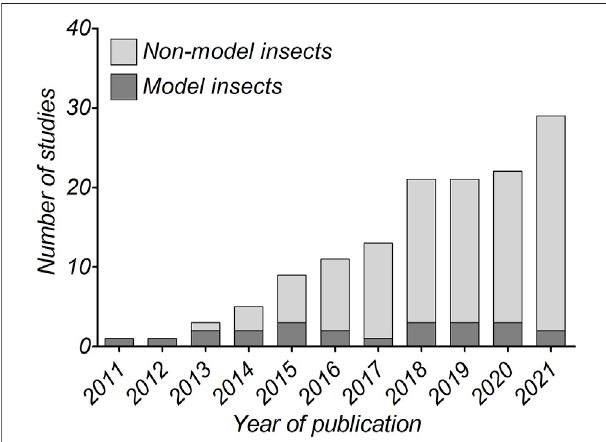
FIGURE1| Numberofstudiespublishedinthelast10 yearsonolfactory protein identi fi cation from antennal transcriptome (detailed data available in Supplementary Table S1